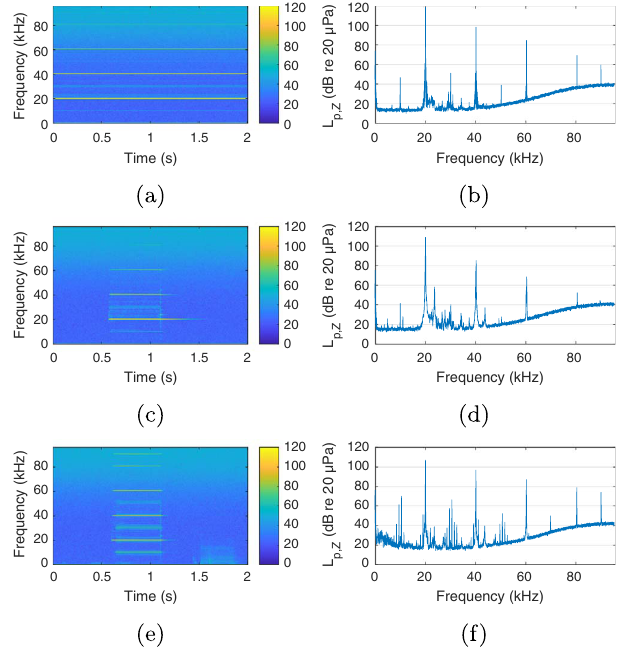
Figure 11. (a, c, and e) Spectrograms and (b, d, and f) periodograms of measurements with a duration of 2 s. Z - weighted equivalent continuous sound pressure levels L p , Z ,eq 2 s (a and b) for the continuous mode, (c and d) for the repetitively pulsed mode and (e and f) for welding a workpiece.